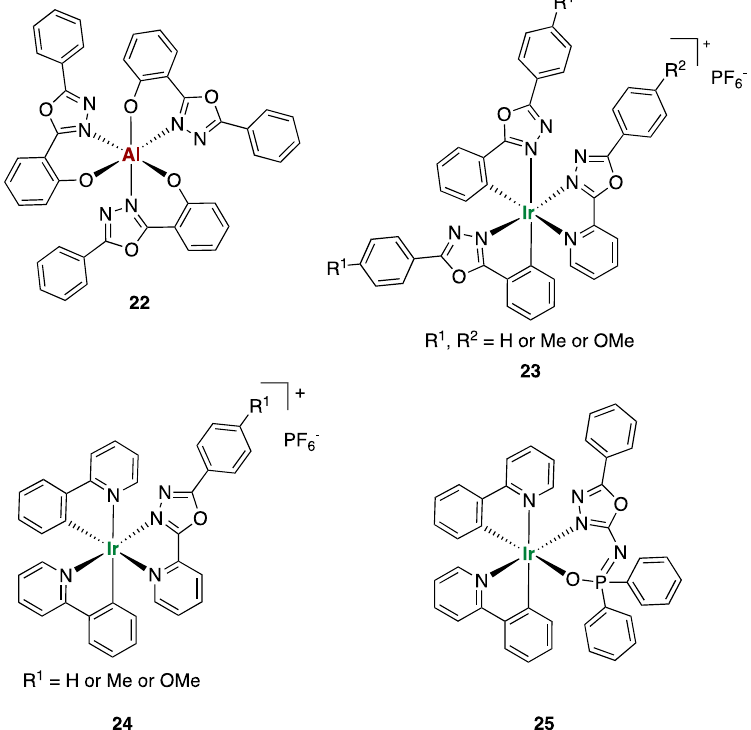
Figure 11. Structures of reported Al(III) and Ir(III) complexes bearing 1,3,4-oxadiazole ligands employed as emitters in organic light-emitting diodes